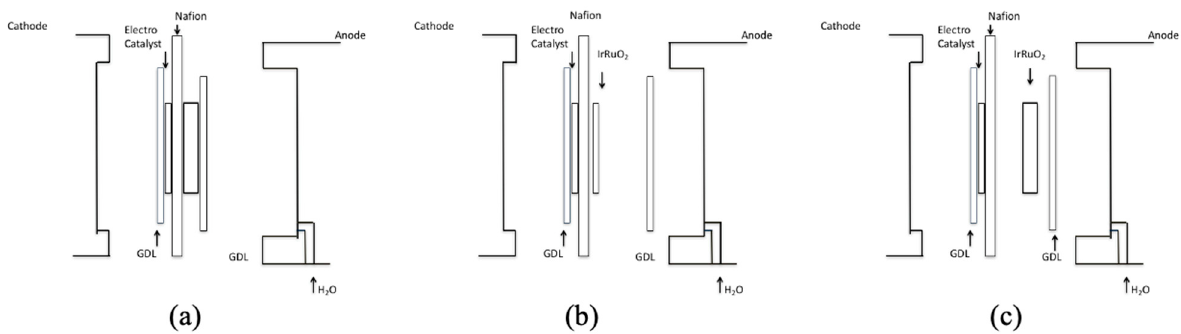
Figure 3. ( a ) PEM electrolyzer with as purchased intact MEA, ( b ) PEM electrolyzer with detached GDL, and ( c ) PEM electrolyzer with detached anode electrocatalyst (IrRuO 2 ) and GDL.